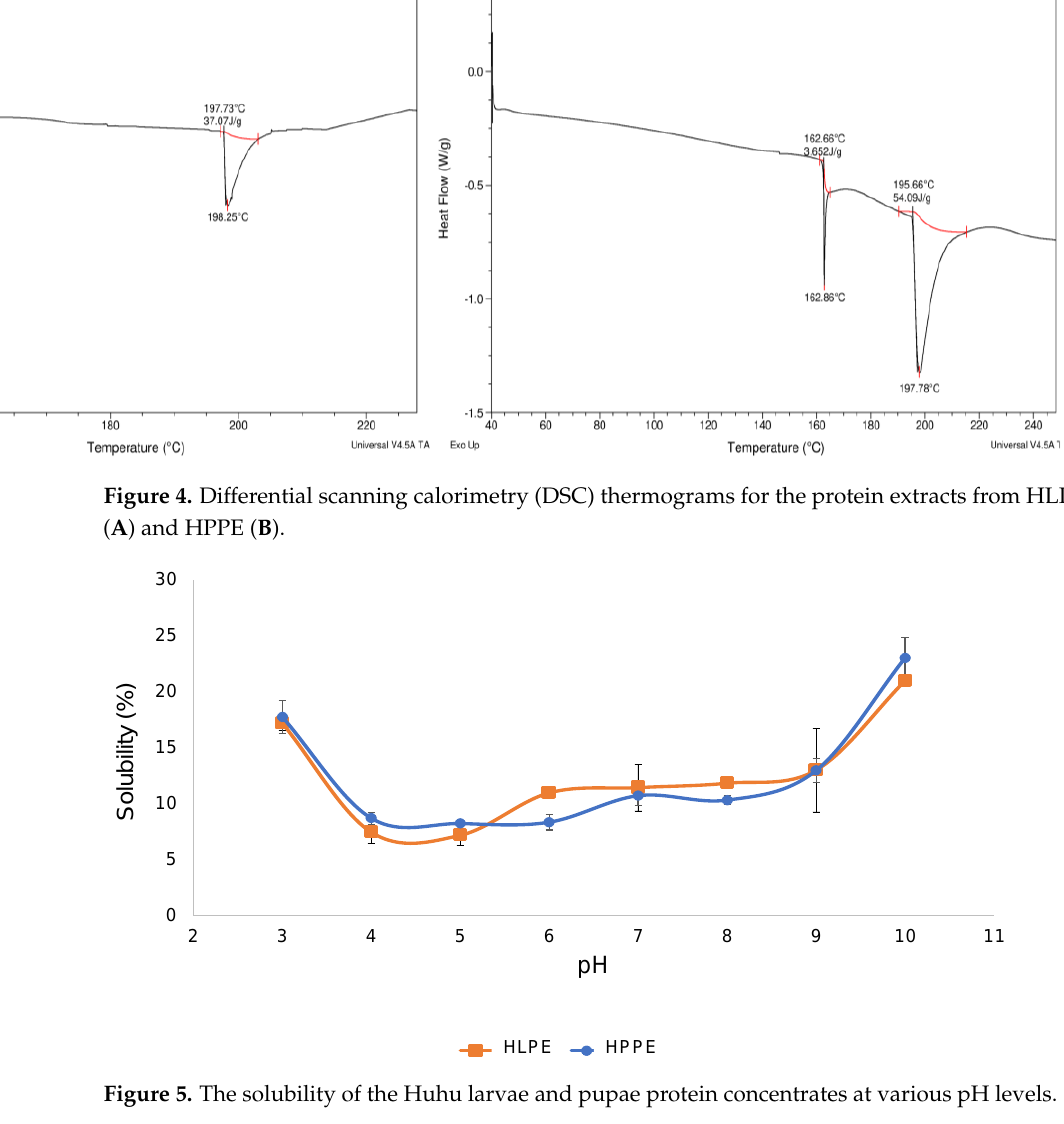
Figure 4. Differential scanning calorimetry (DSC) thermograms for the protein extracts from HLPE ( A ) and HPPE ( B